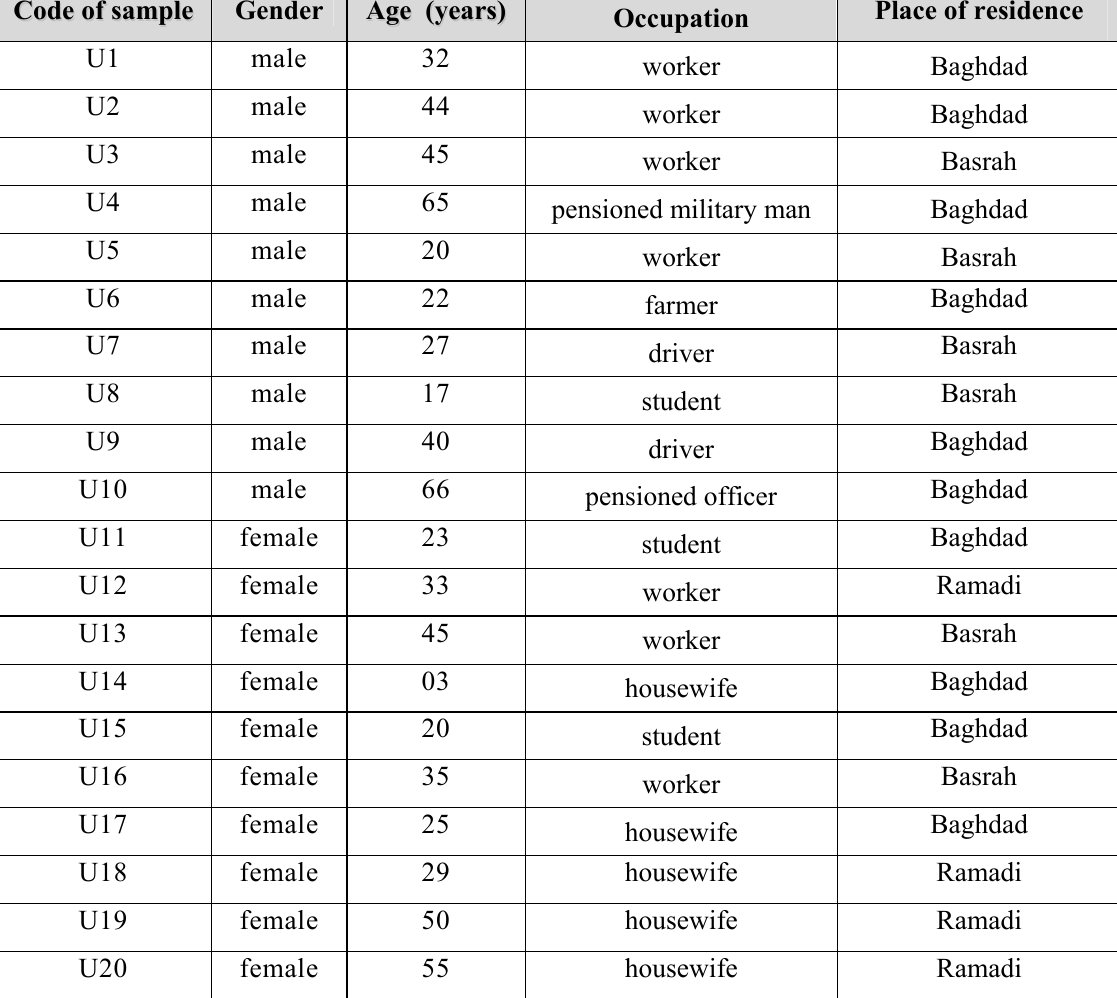
Table 1: Urine human samples